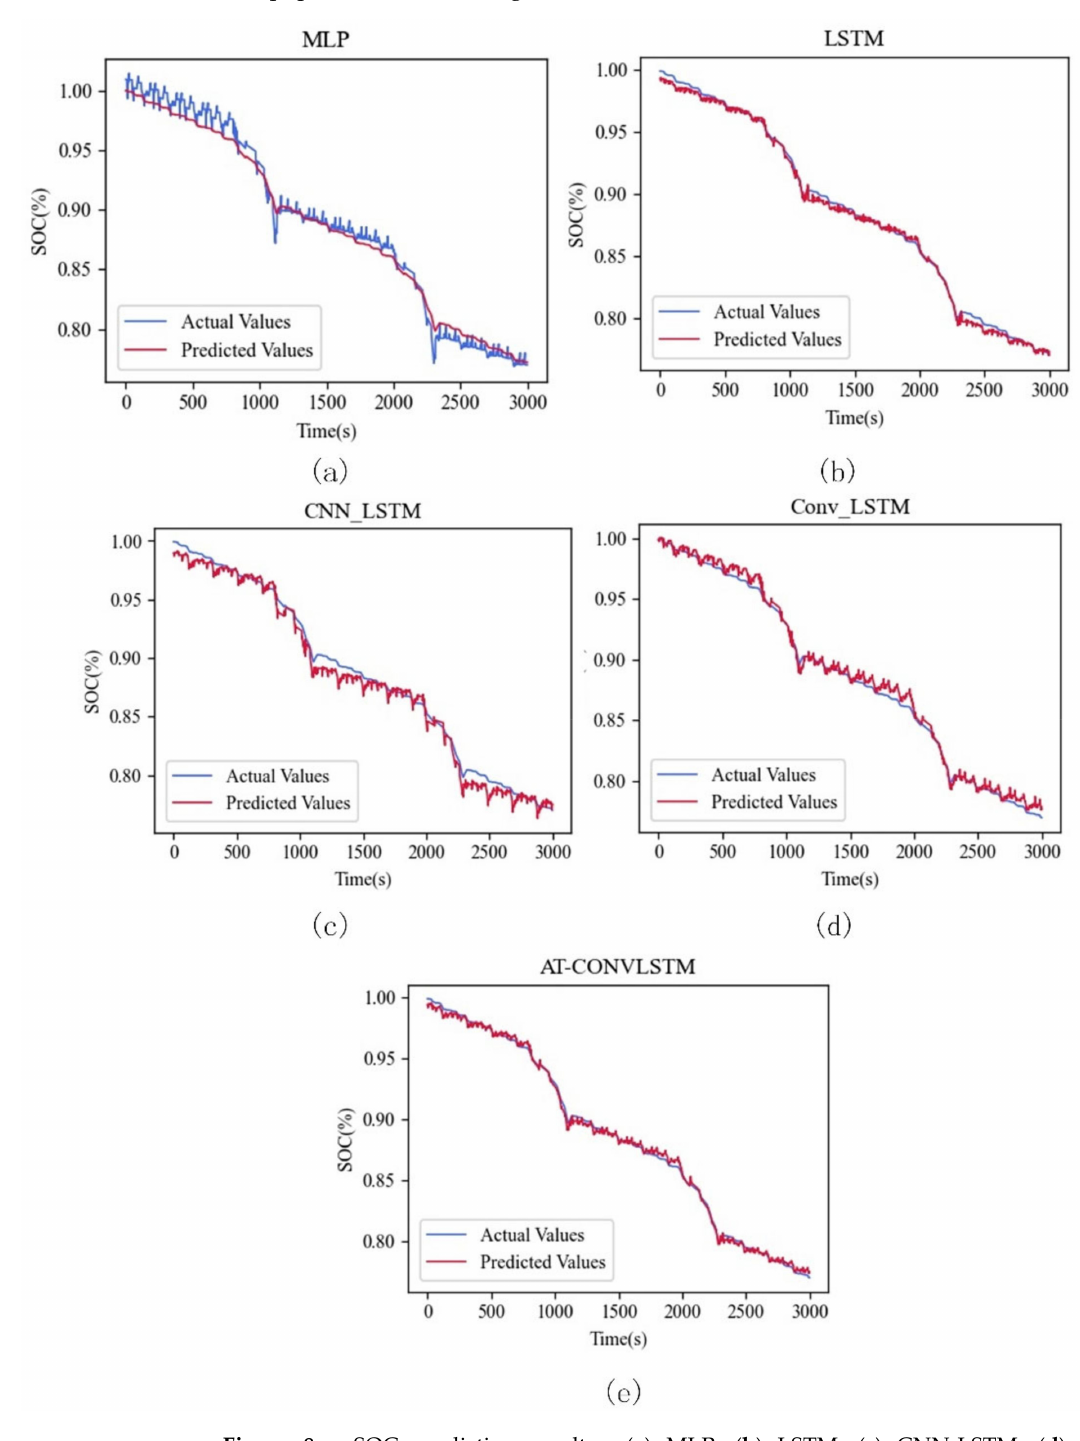
SOC prediction results: ( a ) MLP; ( b ) LSTM; ( c ) CNN‑LSTM; ( d )